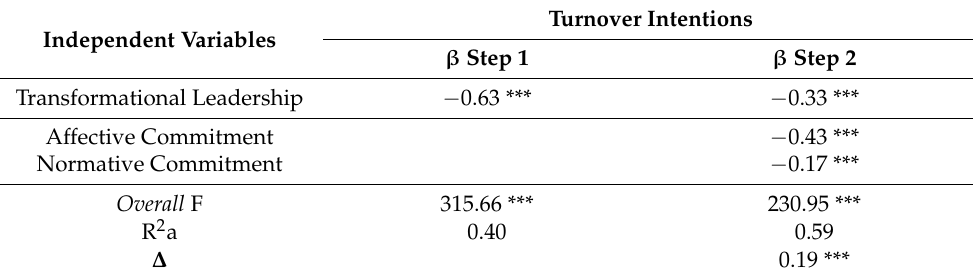
Table 7. Mediating Effect of Organisational Commitment